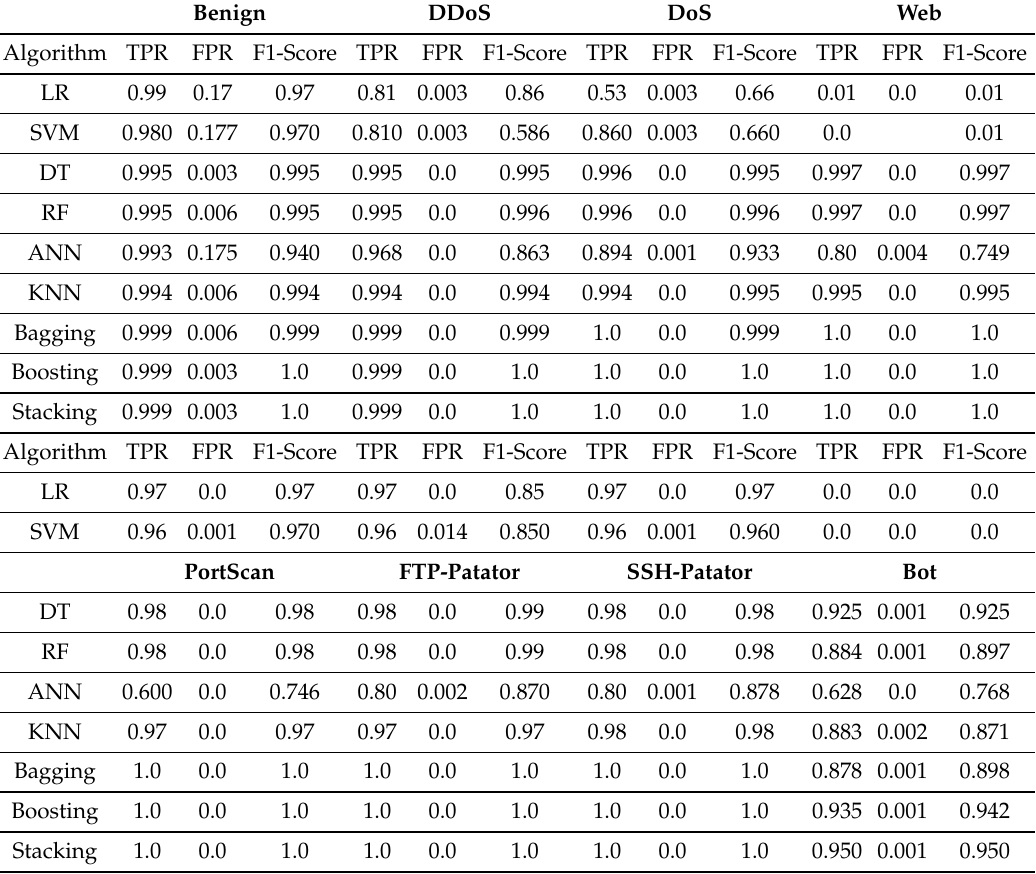
Table 6. Detection of various classes in multi-class scenario on CICIDS2017 dataset. Benign DDoS DoS